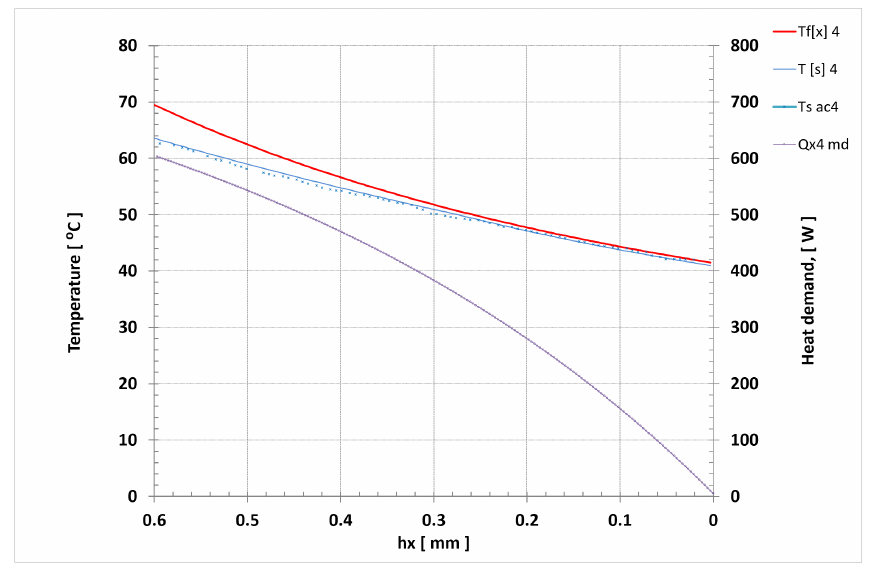
Figure 12. Comparison of measurement and calculations results of water temperature, radiator surface temperature and radiator heat out distribution—measurement 4: t s = 69.7 ◦ C, t r = 42.2 ◦ C, t i = 20.3 ◦ C, m r = 0.0051 kg/s ( m rmin ) .